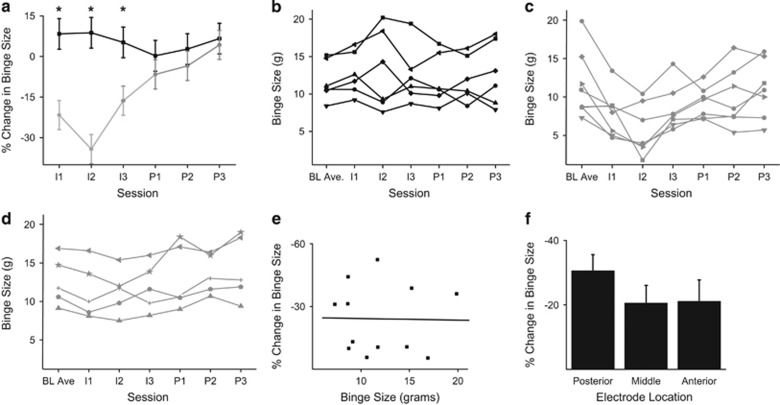
Chronic binge-eating state. (a) Binge size in DBS intervention group (gray circles) versus sham intervention group (black squares) across three intervention sessions (I1-3) and three post-intervention sessions (P1-3). Asterisks highlight sessions with significant differences between the sham and stimulation groups (P<0.05). (b) Individual rat binge sizes in the sham group across sessions shown in a. (c) Individual rat binge sizes (N=7) in the stimulation group that showed a reduction in binge size (>10% reduction in binge size on any intervention day) across sessions shown in a. (d) Individual rat binge sizes (N=5) in the stimulation group that failed to show a reduction in binge size across sessions shown in a. (e) Plot of pre-intervention binge size in the chronic binge-eating state (grams) versus average percent reduction in binge size in the stimulation group showing no significant relationship (N=12; R=−0.018, P=0.957). (f) Average percent reduction in binge size, binned by electrode location along the anterior–posterior axis (N=8 per group). Error bars in all panels: ±s.e.m.